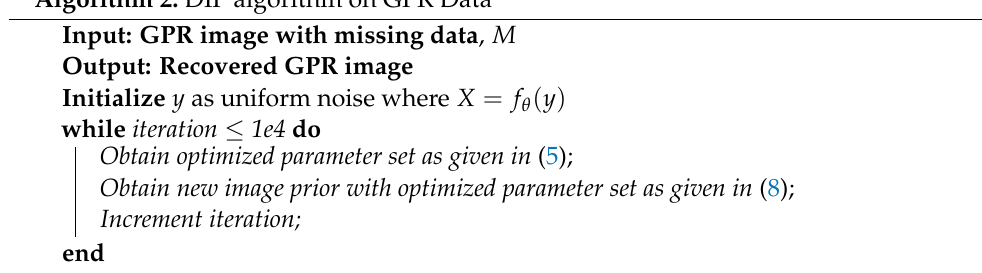
Algorithm 2: DIP algorithm on GPR Data